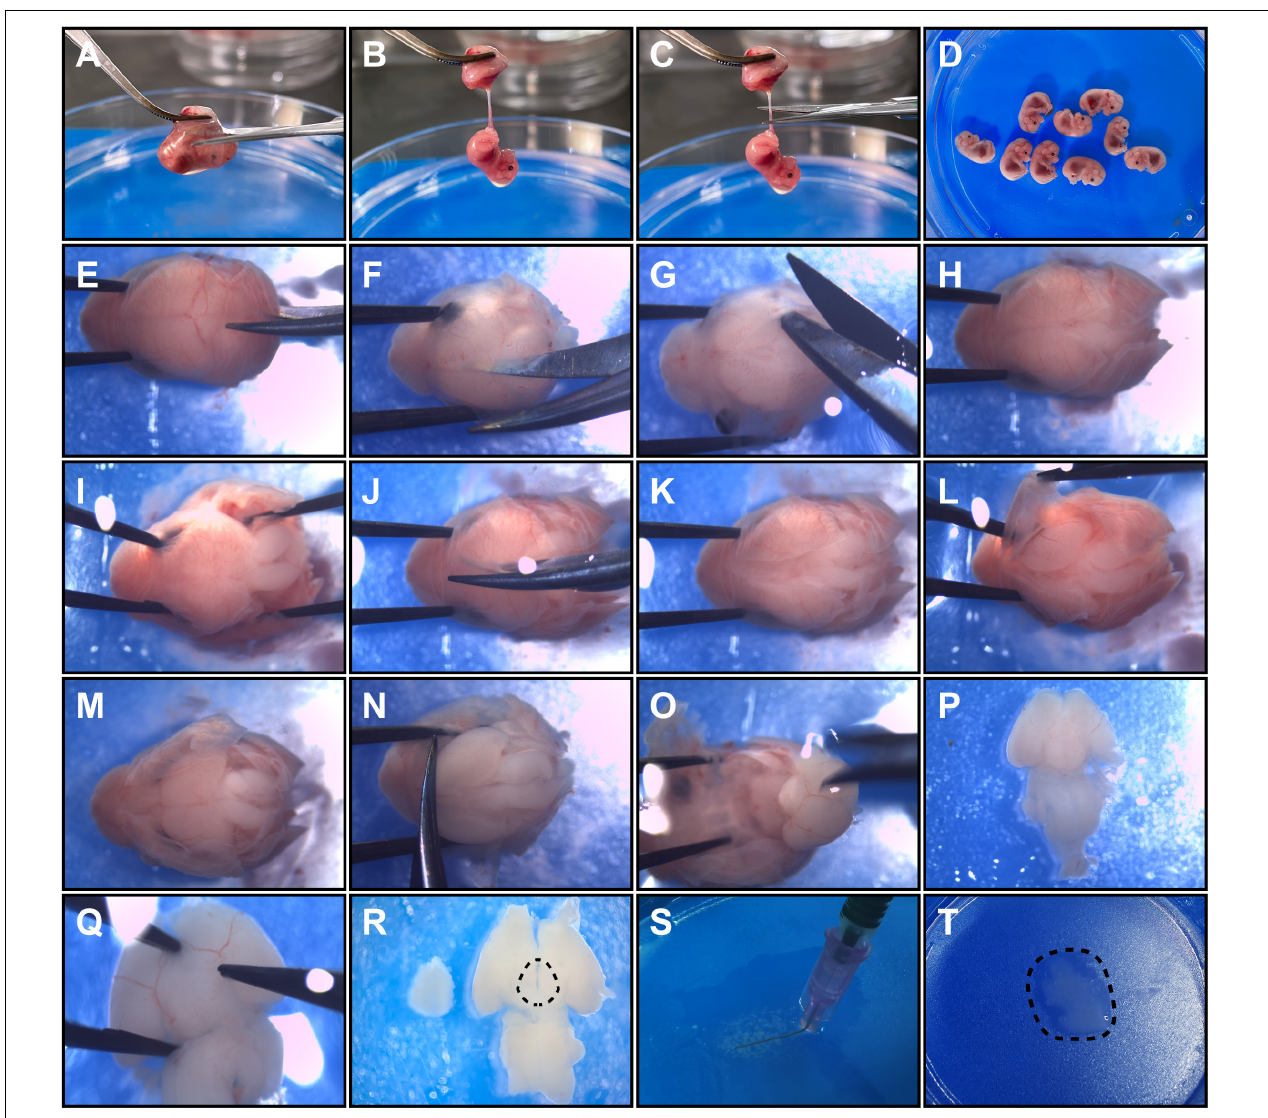
FIGURE 1 | Detailed operation procedures to harvest hypothalamic tissue from E12.5 embryos. Panels (A–D) show embryo acquirement procedures. (A) The placenta was clamped, and a cut was made to open the fetal membrane. (B) An exposed embryo linked to the umbilical cord is shown. (C) The umbilical cord was cut close to the embryo. (D) The embryos were collected in a new dish. Panels (E–P) show the brain microdissection procedures. (E,F) Head fixation and sagittal cutting of occipital and parietal bones are shown. (G) A coronary cut was performed along the lambdoid suture. (H) The separated occipital and parietal bones are shown. (I) The occipital bones were detached from the brain. (J) The frontal bones were sagittally cut. (K) A head is shown with the cranial bones incised. (L) The parietal bones and the frontal bones were detached from the brain. (M) The exposed dorsal side of the brain is shown. (N) The olfactory bulb was cut to free the brain. (O) The fetal brain was isolated from the skull. (P) A ventral view of the fetal brain is shown. (Q) Removement of hypothalamic surrounding membranes and vessels. (R) The dotted line shows the relative dissection margins for hypothalamus microdissection. (S) The brain tissue was minced into small pieces with a bent needle. (T) The final hypothalamic tissue fragments obtained are